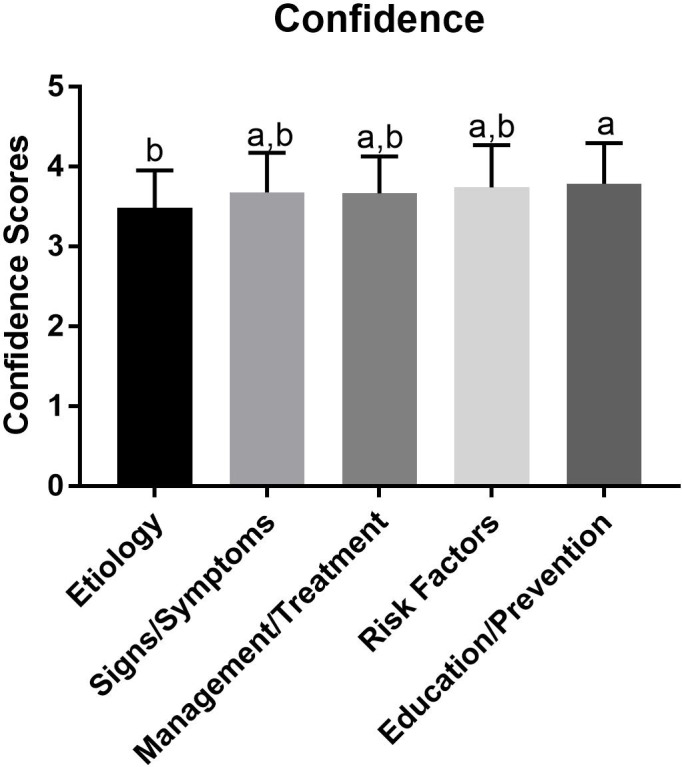
Average confidence of knowledge on various domains of eating disorder information.Confidence values for subscales from the present study. The confidence for each question was summed and then divided by the total possible confidence (corresponding to a confidence score of 5 for each question), equating to the participant’s average confidence for that category. Average confidence was then averaged to determine an overage mean confidence for that category. a, denotes a significant difference from etiology. b, denotes a significant difference from education. Therefore, subscales sharing letters are not significantly different (p > 0.05).